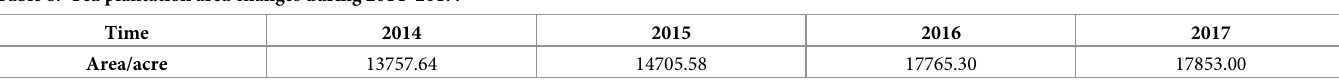
Fig 11. Spatial distribution during (a)2014-2015 (b)2015-2016 and (c)2016-2017. The base map of the LandSat8 OLI images with the following composition:R (4),G (3) and B (2). The LandSat8 OLI images were downloaded from USGS National Map Viewer. https://doi.org/10.1371/journal.pone.0263969.g011 Table 8. Tea plantation area changes during 2014–2017.